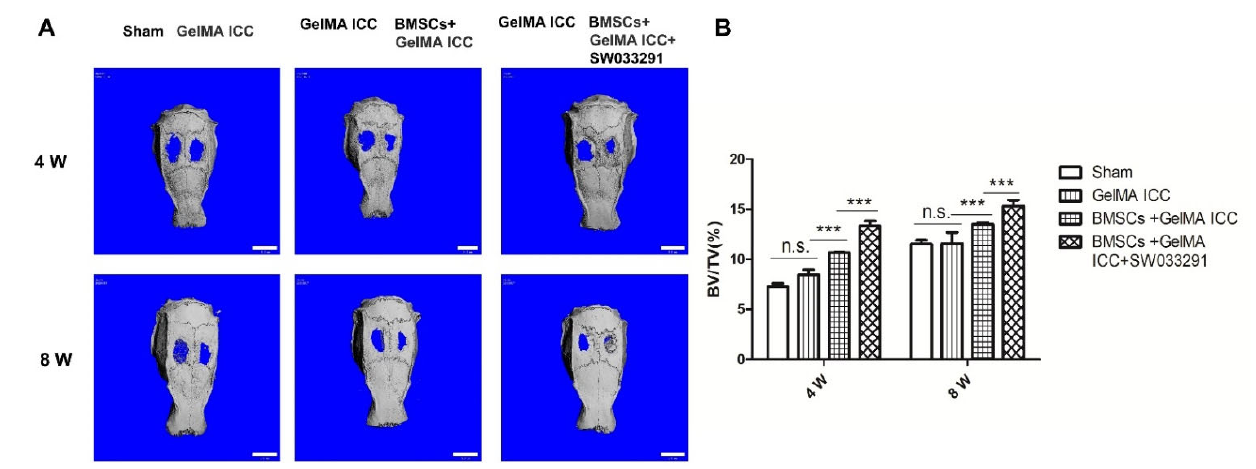
Figure 6. Micro ‐ CT showed the new bone formation in each group at 4 and 8 weeks after surgery (scale bar: 5 mm). ( A ) Reconstruction of micro ‐ CT images; ( B ) Quantitative analysis of micro ‐ CT images including BV/TV. Data are represented as mean ± standard deviation, n = 5 *** p < 0.01.